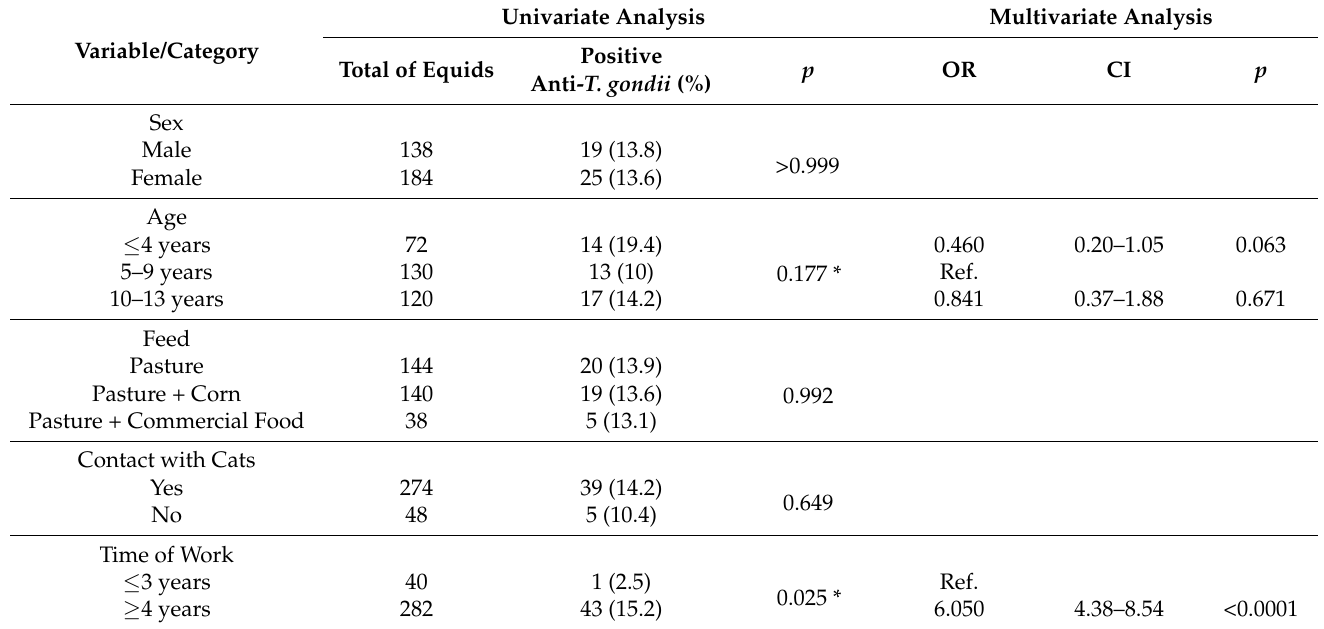
Table 3. Univariate and multivariate analyses of risk factors associated with the positivity for anti- Toxoplasma gondii antibodies in traction equids in the semi-arid region of Northeastern Brazil.